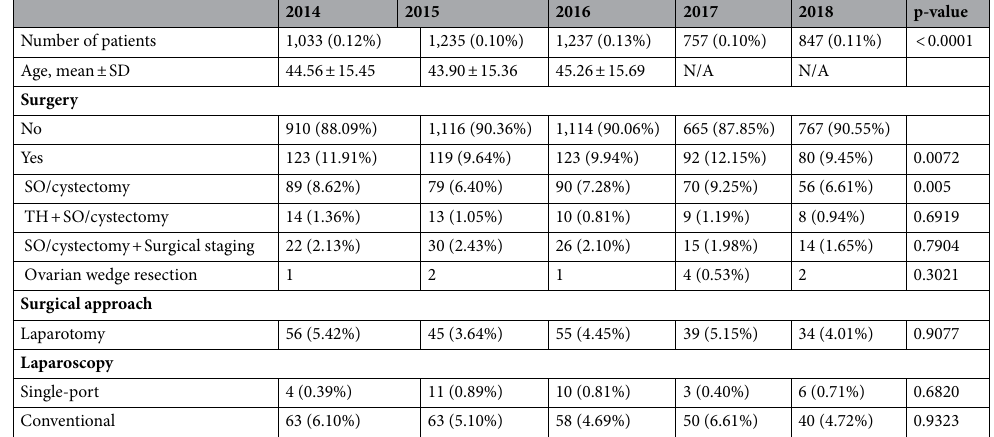
Table 1. Characteristics associated with borderline ovarian tumors from 2014 to 2018. TH Total hysterectomy, SO salpingo-oophorectomy, N/A not applicable: In 2017 and 2018, only frequency by age group was provided, not by age of individual patients.